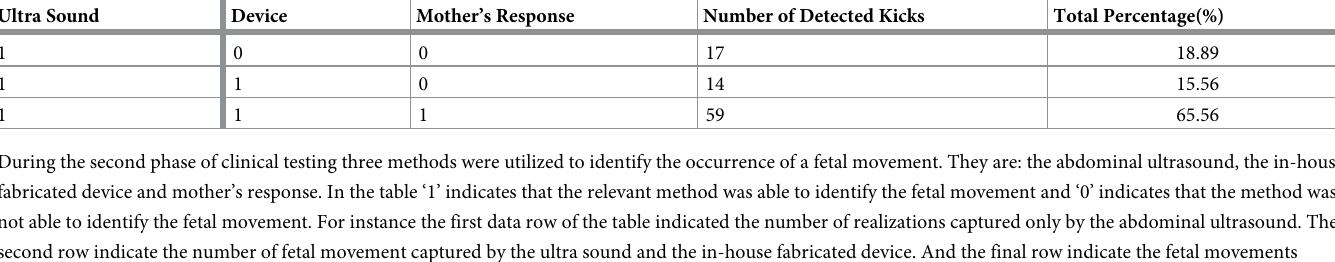
Table 2. Number of realizations identified and observed by each method during the second phase of clinical testing.